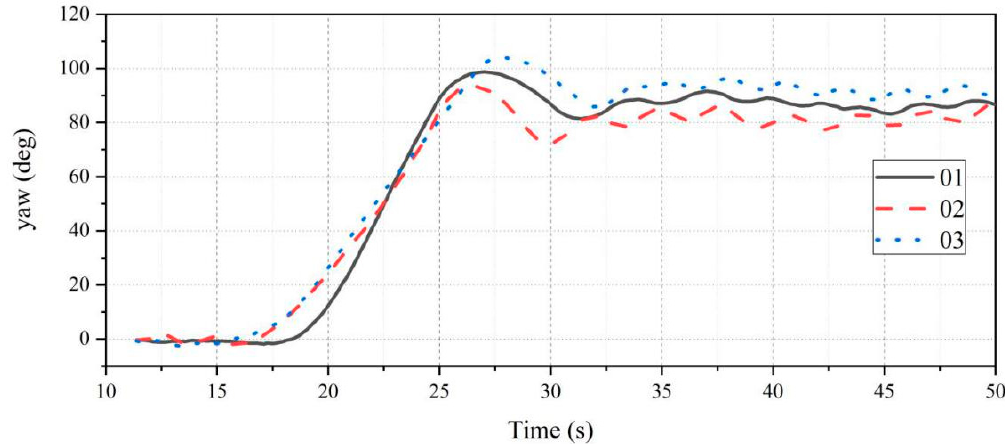
Figure 13. The step response of the yaw angle in the rotation experiment.